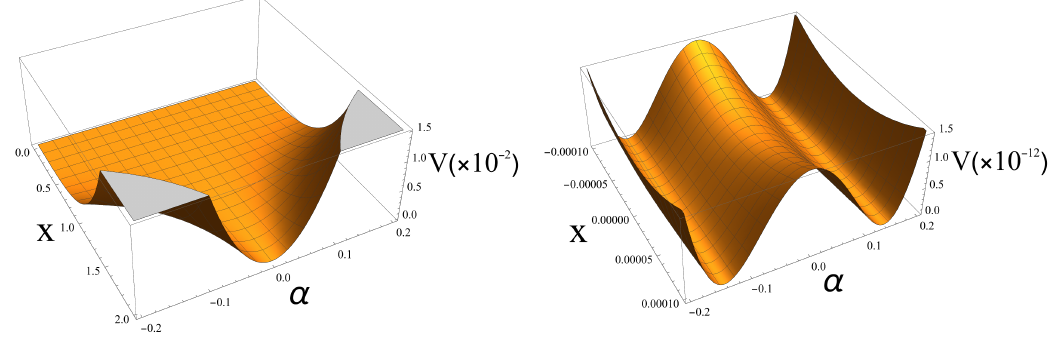
Figure 1 . The scalar potential of x, α near the SUSY vacuum (left panel) and for large values of x (right panel), with β = y = σ = 0 and λ 1 = 0 . 3 × 10 − 5 , µ = × 10 − 5 , κ 1 = 10 − 4 , κ 2 ∼ 1 . All values are given in the units where M = 1 P